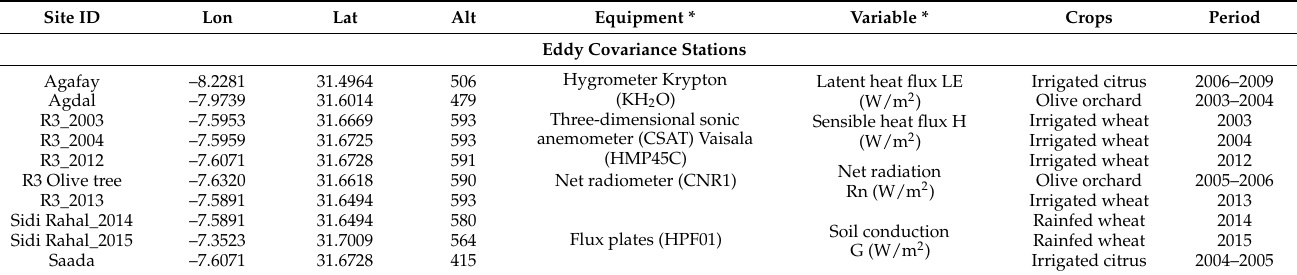
Figure 1. The Tensift catchment within the Tensift Observatory network and the irrigated perimeters. Please note that R3 stations are not installed on the same fields and crops (see Table 1); however, for ease of visualization, only one point is reported on the map. Table 1. List, location, and acquisition period of the Tensift observatory eddy covariance tower and meteorological stations used in this study for evaluating the predicted energy budget components and for the evaluation of ERA-Interim analysis dataset. * Please note that each equipment and each variable are found at each site. However, for ease, they are reported only once in the